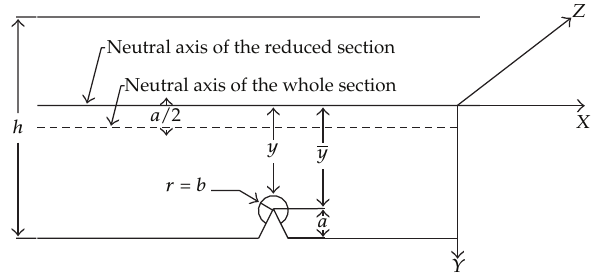
Figure 1: Geometry of a beam with a single-edge